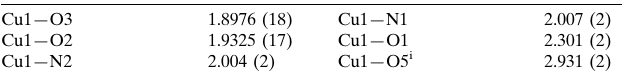
Selected bond lengths (A˚ ).